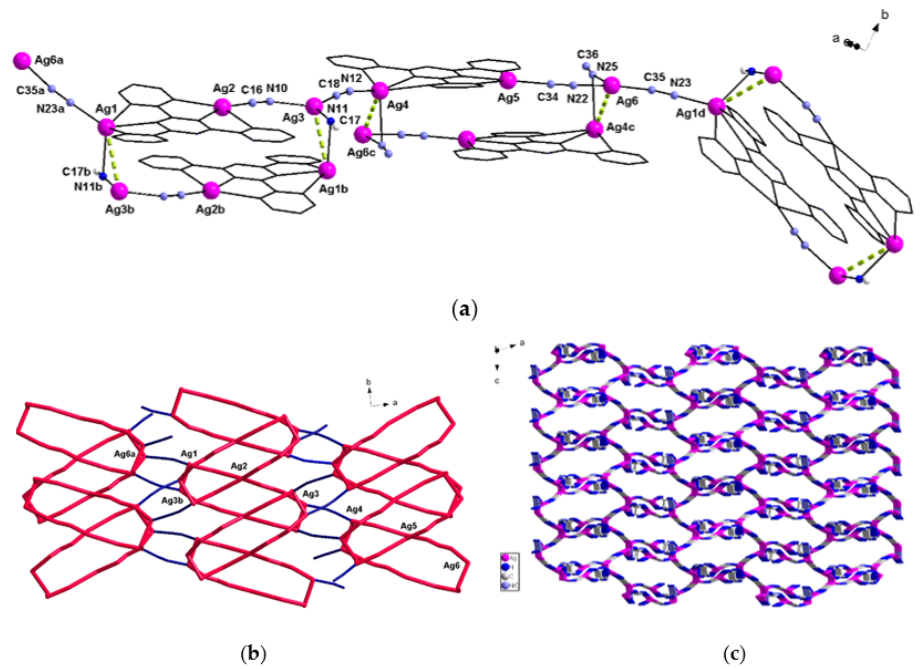
Figure 3. A fragment of the 3D structure of compound 2 showing ( a ) the argentophilic interactions and the cyanide μ 2 -C,C,N bridges; ( b ) packing motif in the ab crystallographic plane (the aromatic rings were omitted for clarity), dark blue lines correspond to the cyanido bridging groups; ( c ) the structure of 2 growing along crystallographic b axis; (Ag atoms are represented with magenta color; N atoms are represented with blue color; C atoms are represented with grey color and the disordered N/C atoms are represented with light blue color). Symmetry codes: a = 1 + x , 3/2 − y , 1 + z ; b = 2 − x , − y , 1 − z ; c = 1 − x , 2 − y , 1 − z ; d = − 1 + x , 3/2 − y , − 1 + z